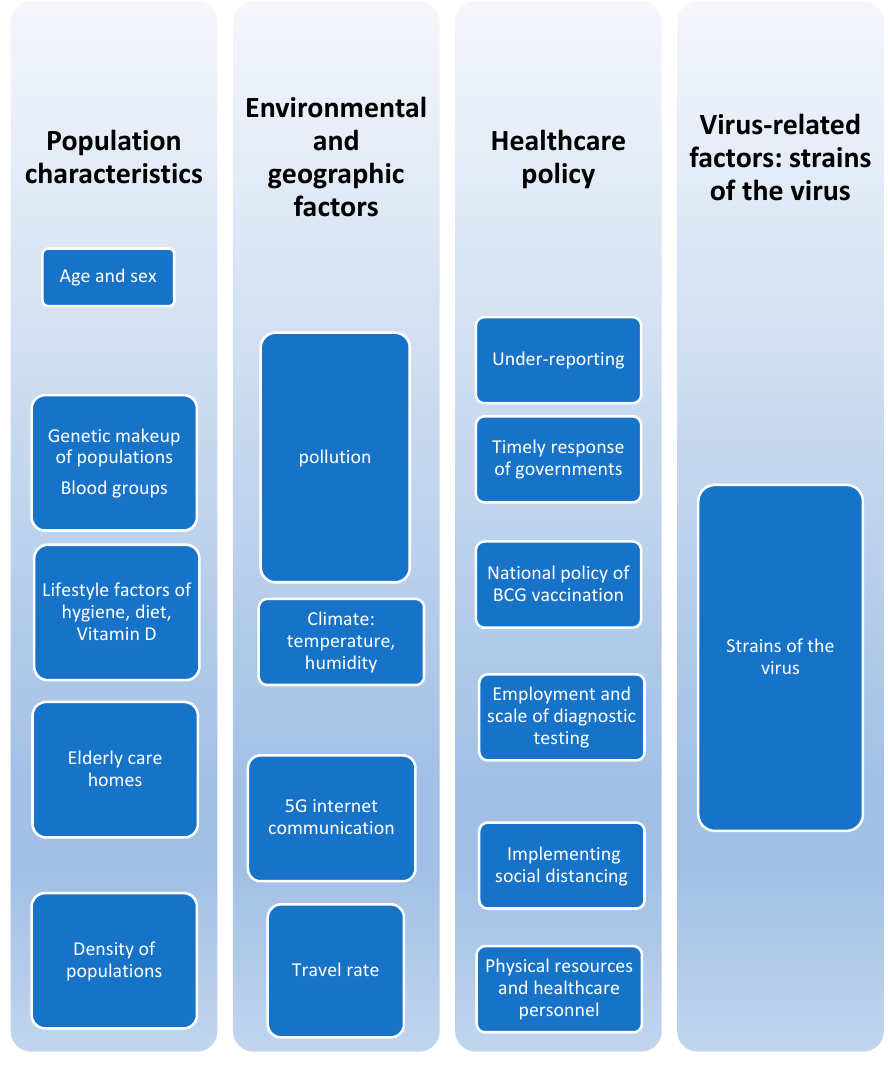
Figure 1. Possible factors implicated in the variability of disease outcomes of infection and fatality among countries.